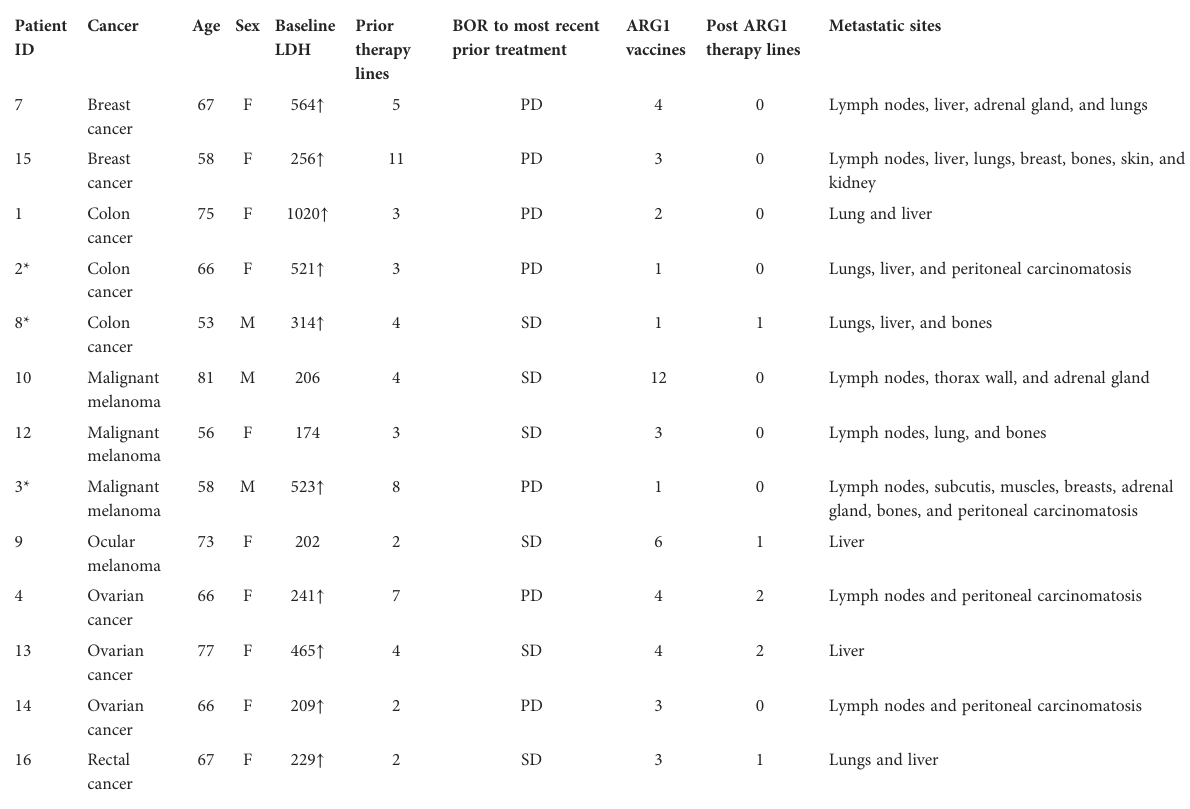
TABLE 1 A list of patients